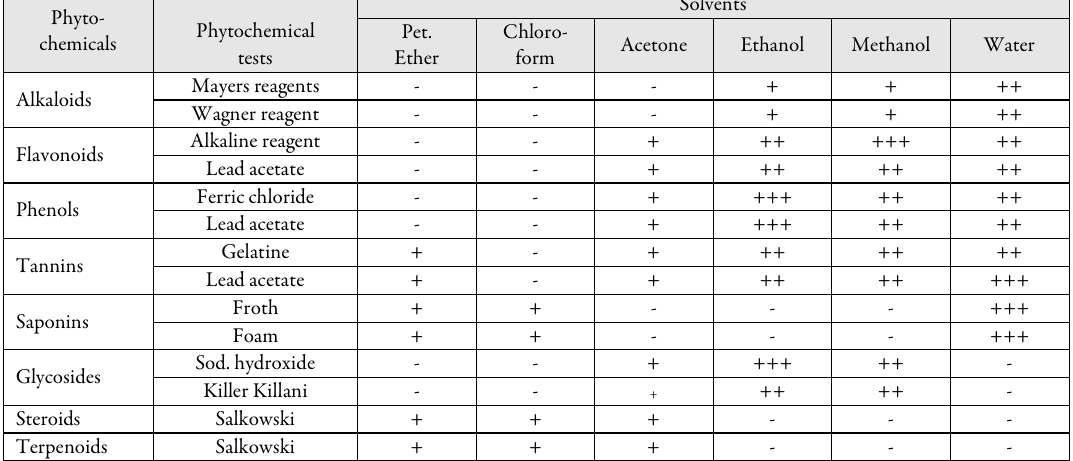
Table 2. Preliminary phytochemical screening of seeds extracts of Mucuna pruriens (L.). DC. Phyto-